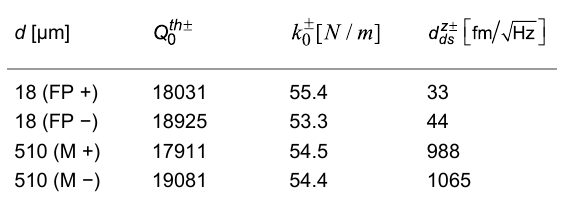
Table 1: Effective modal Q-factor , effective modal cantilever stiff- ness and noise